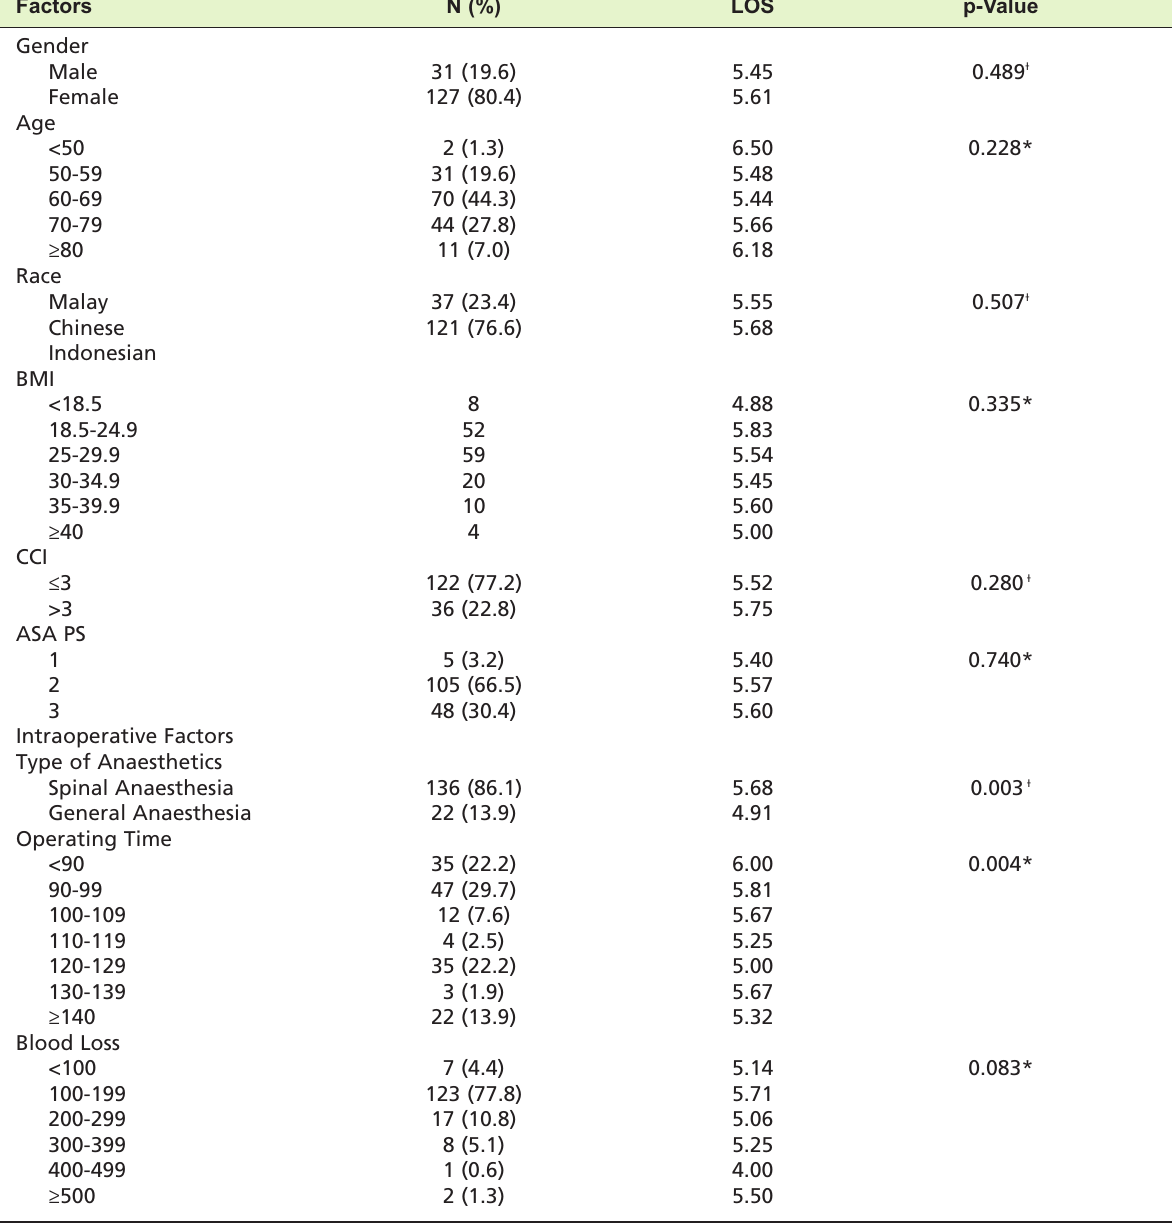
Demographic and preoperative data of the patients Table I: